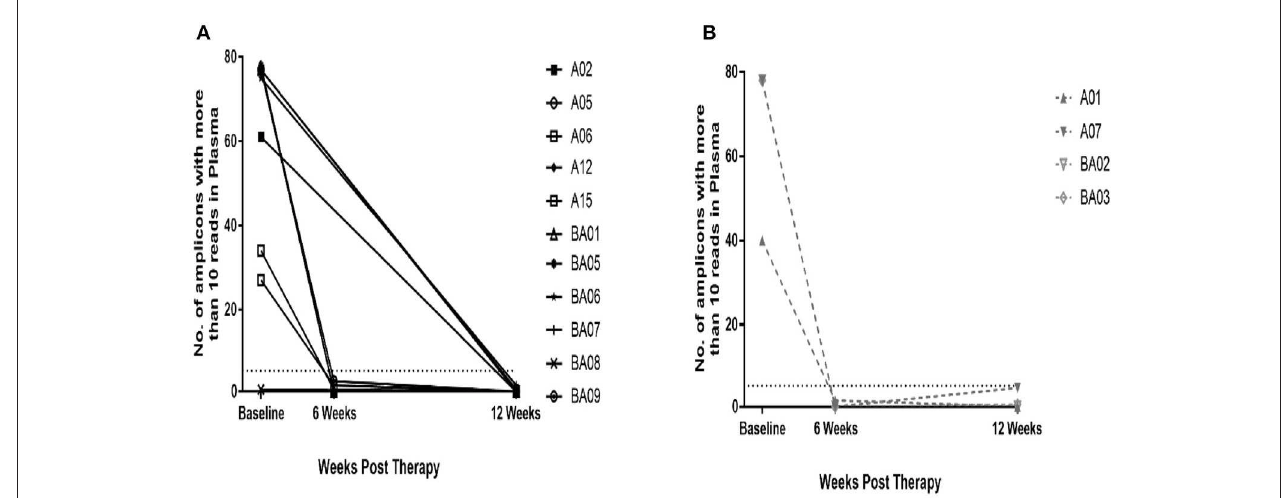
FIGURE 1 | Plasma HPV-DNA levels at baseline and 12 weeks post-CRT. 14/15 patients had above threshold levels of cHPV-DNA at baseline. At 12 weeks post- CRT, cHPV-DNA levels dropped to below threshold in all 14 patients. (A) 11 patients had complete response on DRE/MRI and cHPV-DNA below threshold. (B) 4 patients with partial response on DRE/MRI at 12 weeks and below threshold cHPV-DNA; further DRE/MRI at 6/12 months showed no evidence of relapse The dashed line on the Y-axis denotes the panHPV-detect threshold at 5.5 amplicons with more than 10 reads.